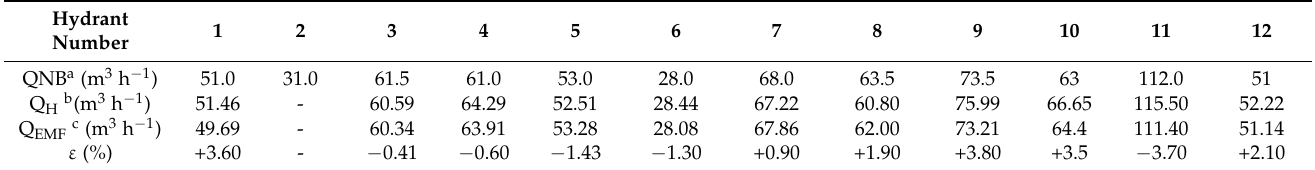
Table 5. Global metrological error of water meters.